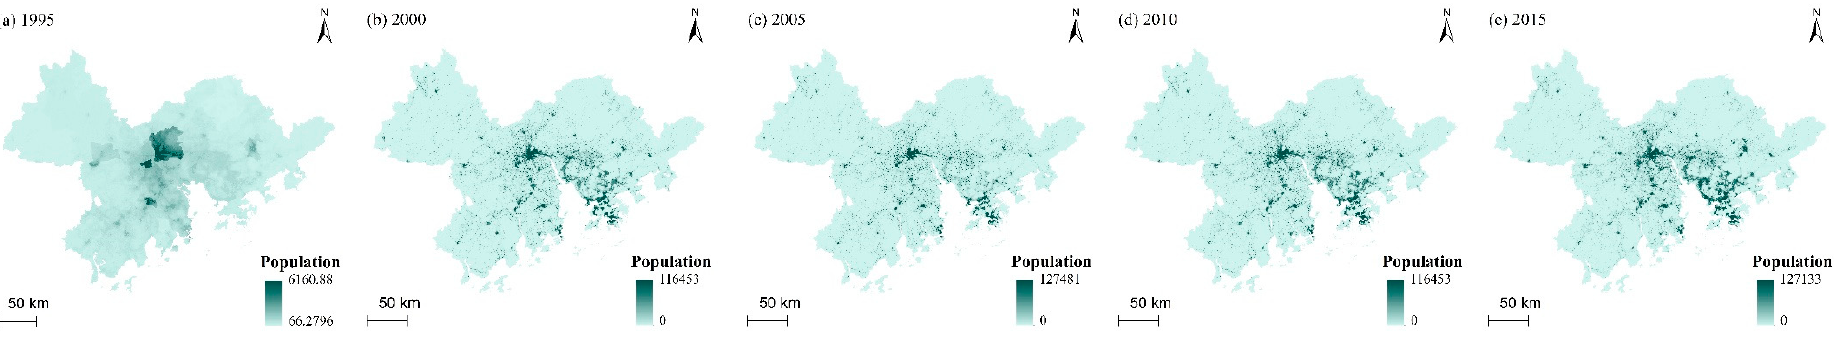
Figure A1. The spatial distribution of population: ( a ) 1995, ( b ) 2000, ( c ) 2005, ( d ) 2010, ( e ) 2015.